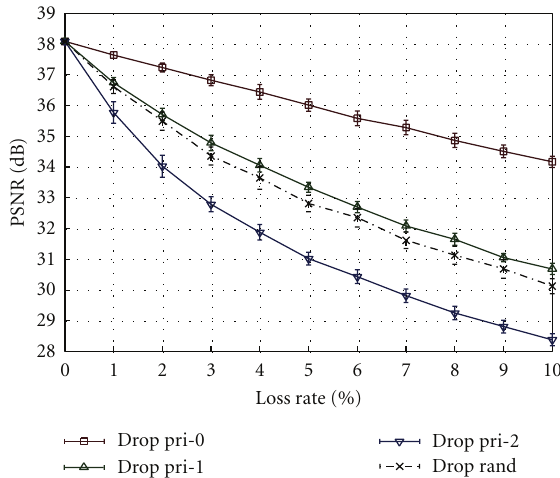
Figure 3: Mean Y-PSNR for the Paris video sequence when dropping packets from di ff erent priorities.